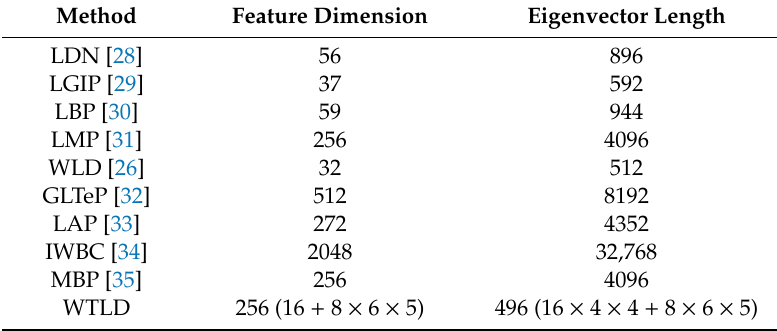
Table 5. Comparison of feature dimension and feature vector length between WTLD and other local descriptors.